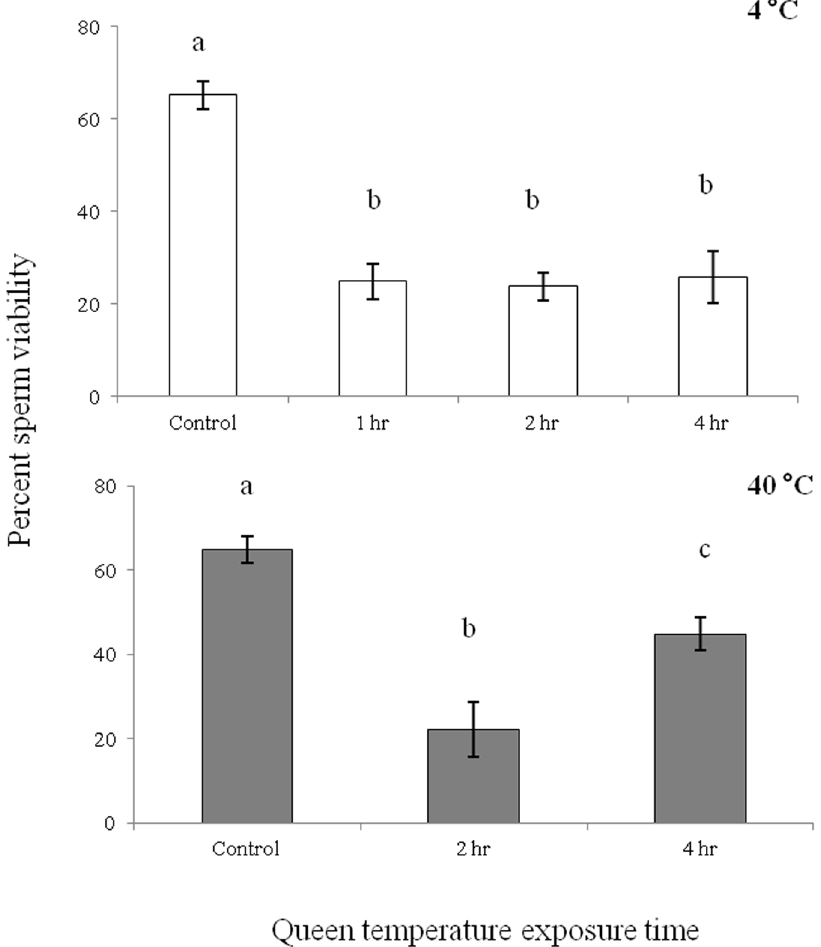
Fig 5. Sperm viability from 60 honey bee queens (n = 10 / temperature and time interval) exposed to high (40°C) and low (4°C) temperatures for varying lengths of time. All queens were from a single source and control queens were held at 30°C for the 7 day test period, with queens exposed to experimental temperatures on day one. Letters over bars indicate significant differences (0 < 0.001 for all comparisons, 4°C = Steel-Dwass Method, 40°C = ANOVA Tukey-Kramer HSD).